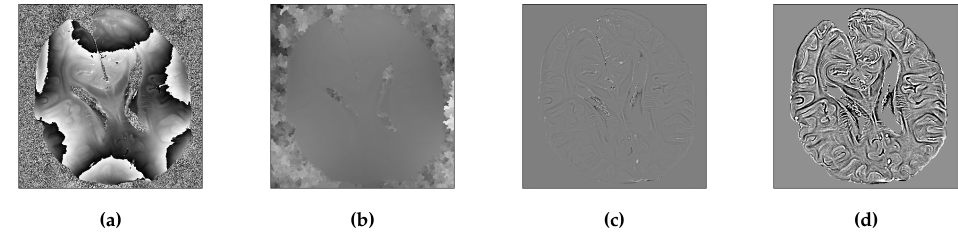
Figure 2. Phase processing for better visualization of the brain structure and hence easier comparisons. (a) Raw wrapped phase image. (b) Unwrapped phase image. (c) High pass filtered phase image, notice that the structures in the brain are more visible here. (d) Contrast stretching of 2nd and 98th percentiles of intensity values that permits contrast enhancement and improved visualization.